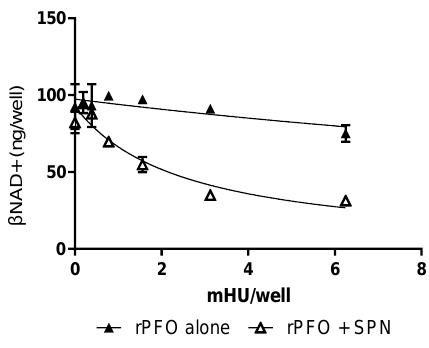
loss of β NAD+ (Figure 4, close triangles) and also augmented the ability of SPN to reduce intracellular β NAD+ in human skeletal muscles (Figure 4, open triangles).